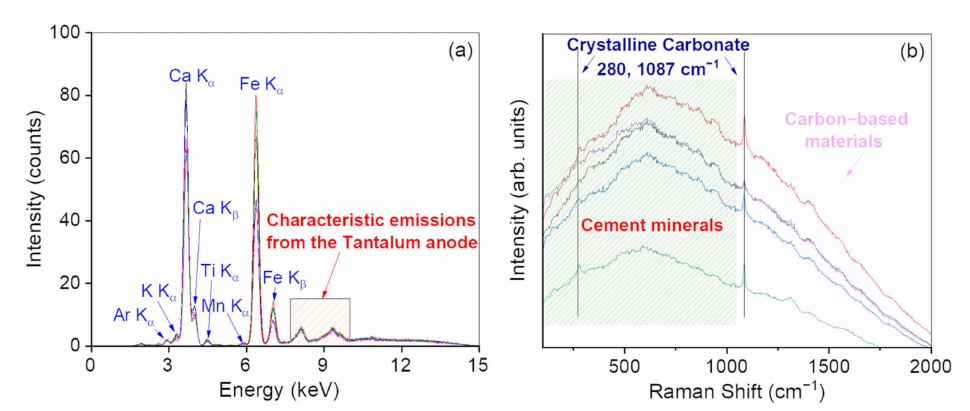
Figure 10. XRF spectra recorded on the mortars ( a ). Raman spectra recorded on the mortars ( b ). In the figure, M1: black line; M2: red line; M3: blue line; M4: pink line; M5: green